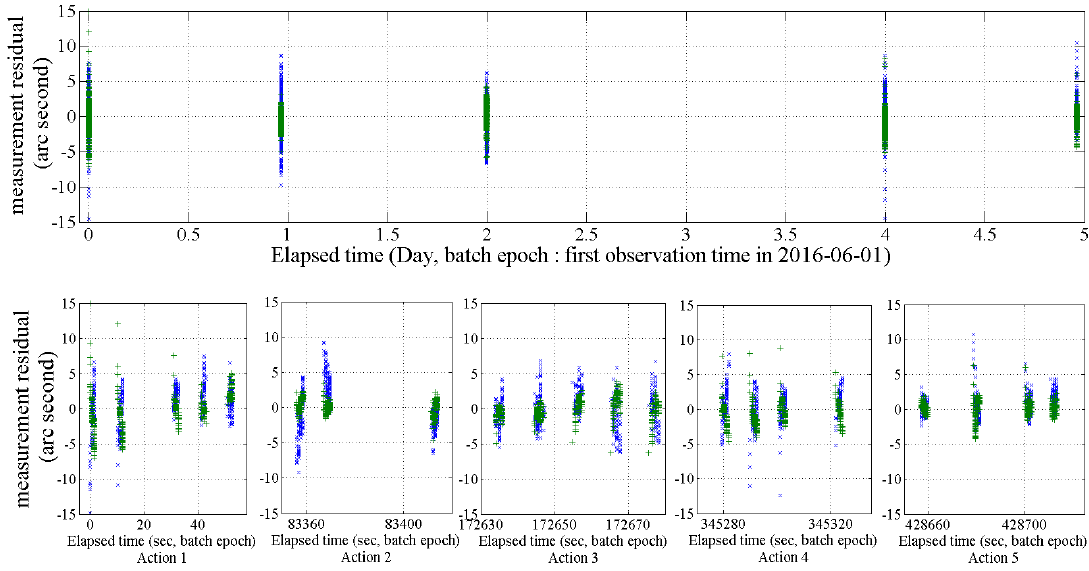
Figure 10. Measurement residuals of the multi-arc batch least-squares orbit estimation results (upper) and five single short-arc batch least-squares orbit estimation results (lower) with the optical observation using the OWL-Net at the Israel site for CRYOSAT 2. The optical observation was peformed from 1 June 2016 to 6 June 2016. Each short-arc optical observation was performed in 40–70 s. (blue cross: right ascension, green cross: declination).